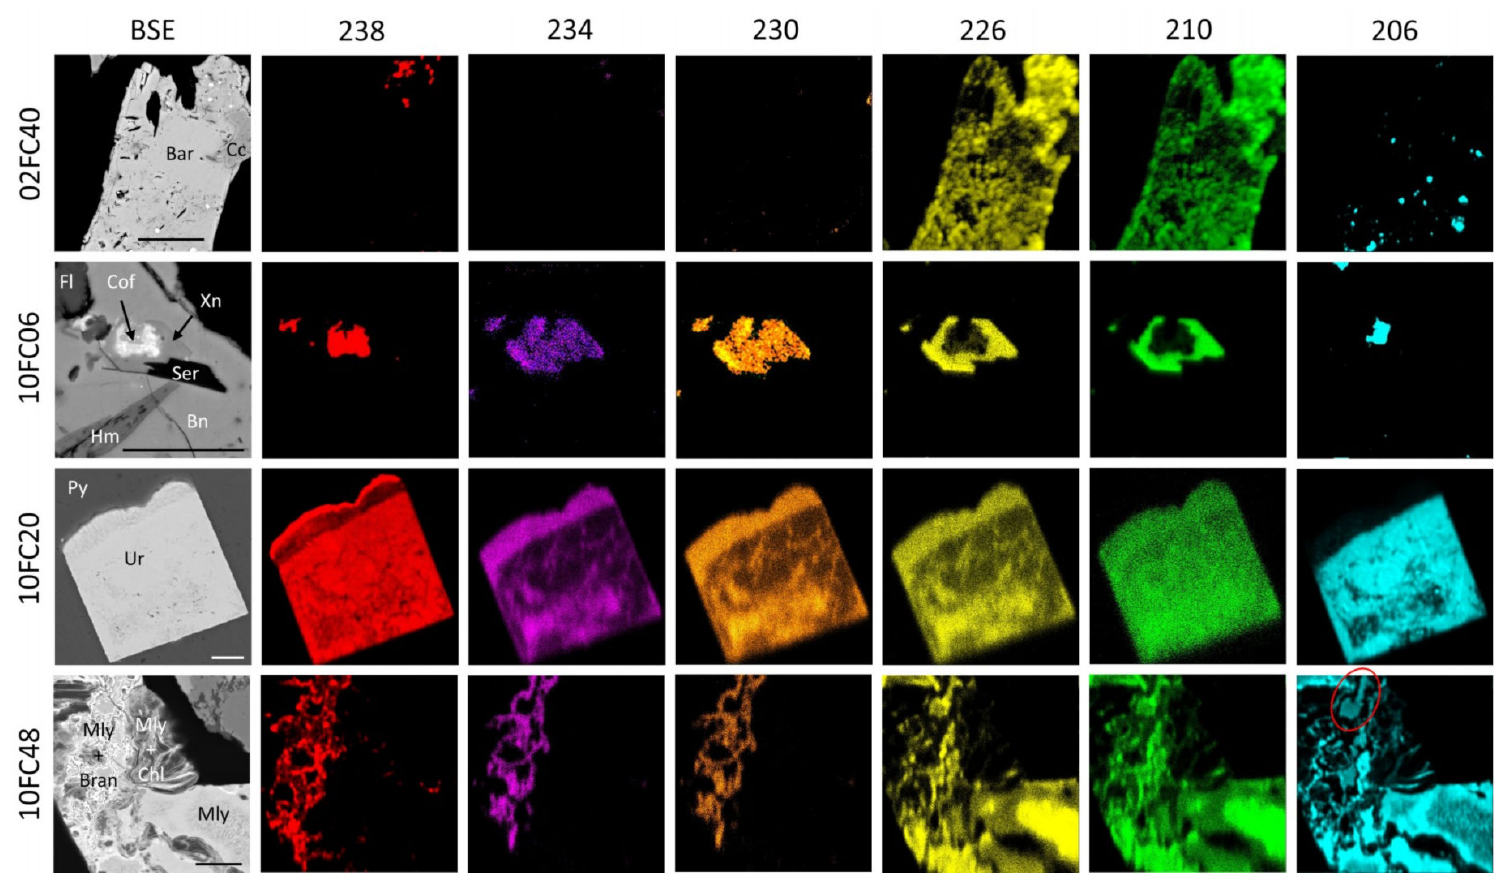
Figure 12. The BSE (left column) and nanoSIMS maps of members of the 238 U decay chain from selected areas in samples 02FC40, 10FC06, 10FC20, and 10FC48. Bar-baryte; Bn-bornite; Bran-brannerite; Chl-chlorite; Cof-co ffi nite; Fl-fluorite; Hm-hematite; Mly-molybdenite; Py-pyrite; Ser-sericite; Ur-uraninite; Xn-xenotime. Scale bars represent 10 µ m. Retention of daughter isotopes is strong in uranium minerals (notably uraninite in 10FC20), but dissociation may be prevalent in other minerals without essential U. In sample 10FC48, note the “quarter note” (crotchet) shape in the red oval on the 206 map. Although a complicated pattern, it can be seen that the maps for masses 206, 210, and 226 are in fact the inverse of the 230, 234, and 238 maps. In Olympic Dam copper concentrates, the 230 Th / 226 Ra decay transition appears to be the most common point of dissociation amongst